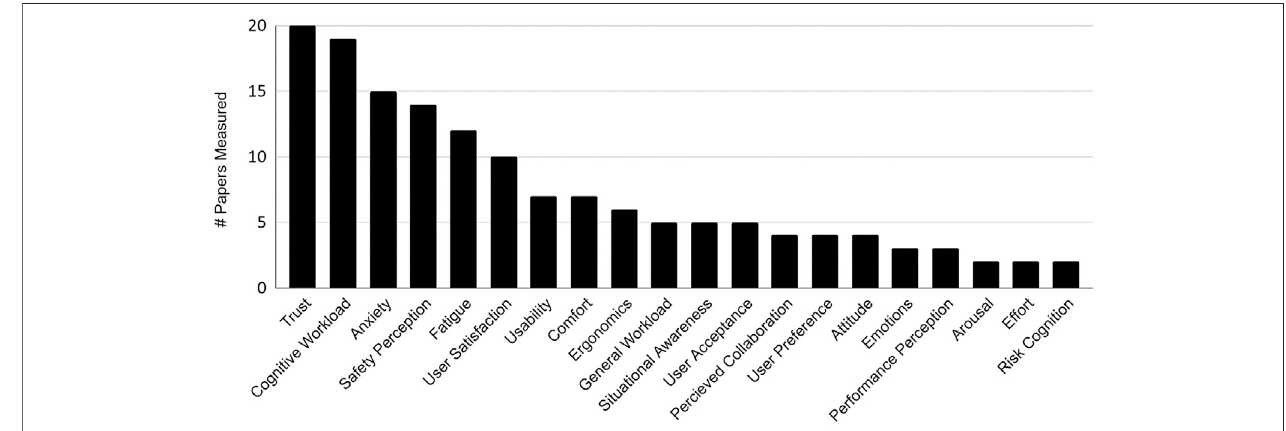
FIGURE 2 | The popularity of human factors in shared-space human-robot collaboration measured out of 61 total papers.